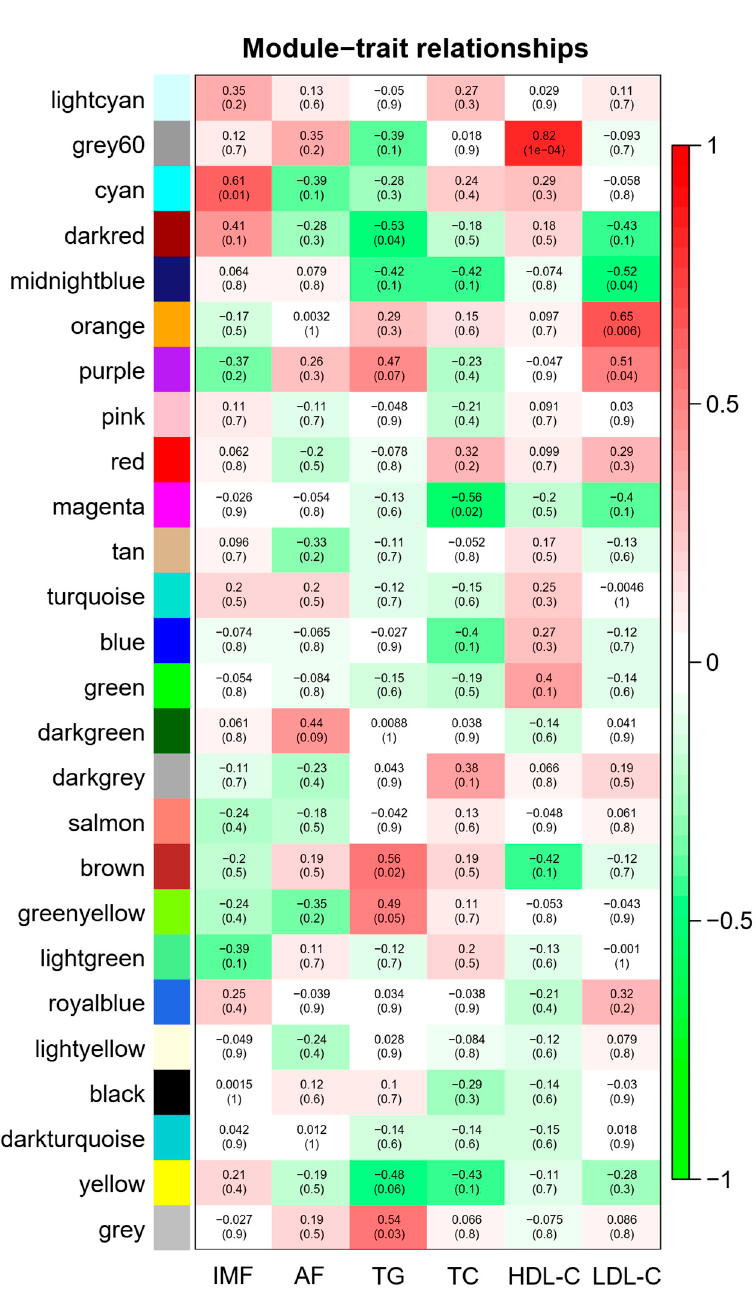
Figure 4. Heat map of correlation between modules and phenotypic data. IMF (intramuscular fat), AF (abdominal fat), TG (triglyceride), TC (total cholesterol), HDL-C (high-density lipoprotein cholesterol), LDL-C (low-density lipoprotein cholesterol). The legend on the right represents the correlation between phenotype and module. The numbers in brackets represent the p -value between the module and the phenotype.